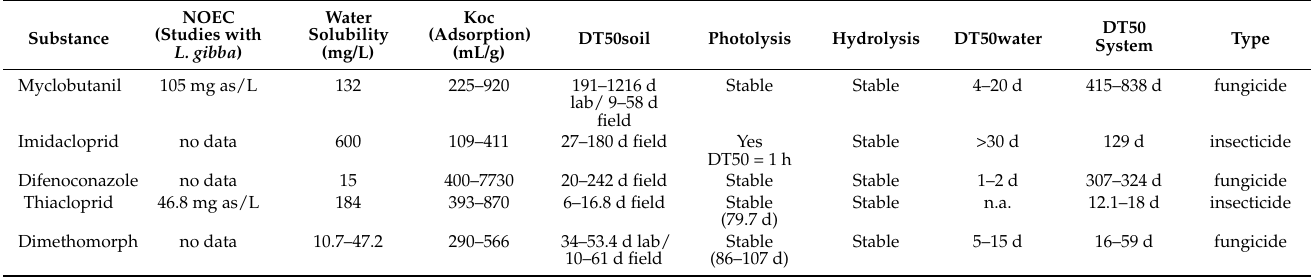
Table 1. The examined pesticides and their environmental fate endpoints